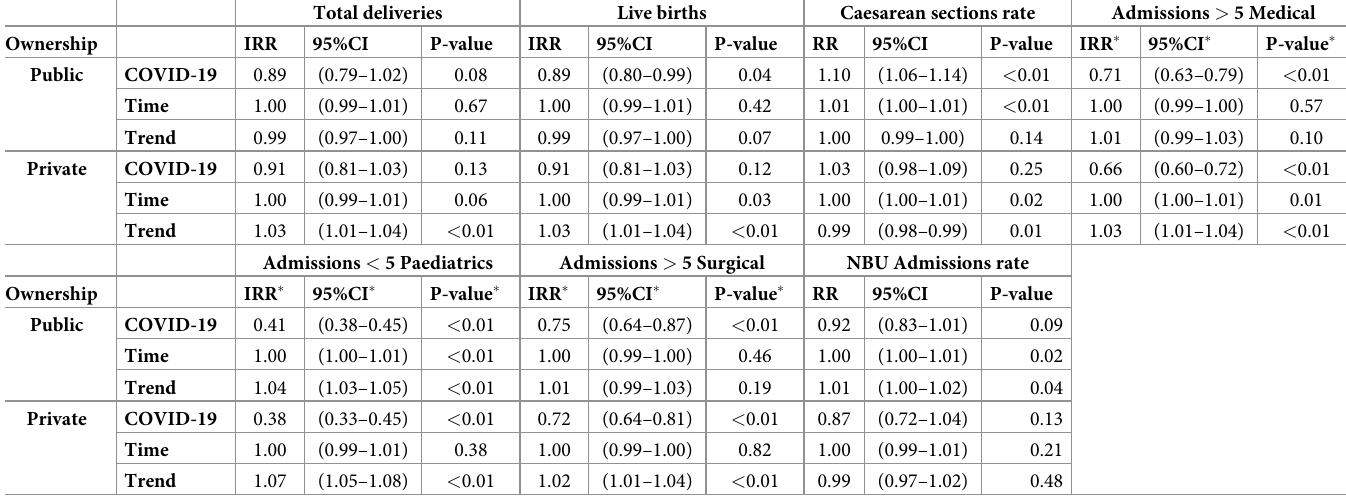
Table 1. Interrupted time series analysis results showing incidence rate ratios (IRR) and relative risk (RR)for COVID-19 intervention, time and trend alongside 95% confidence